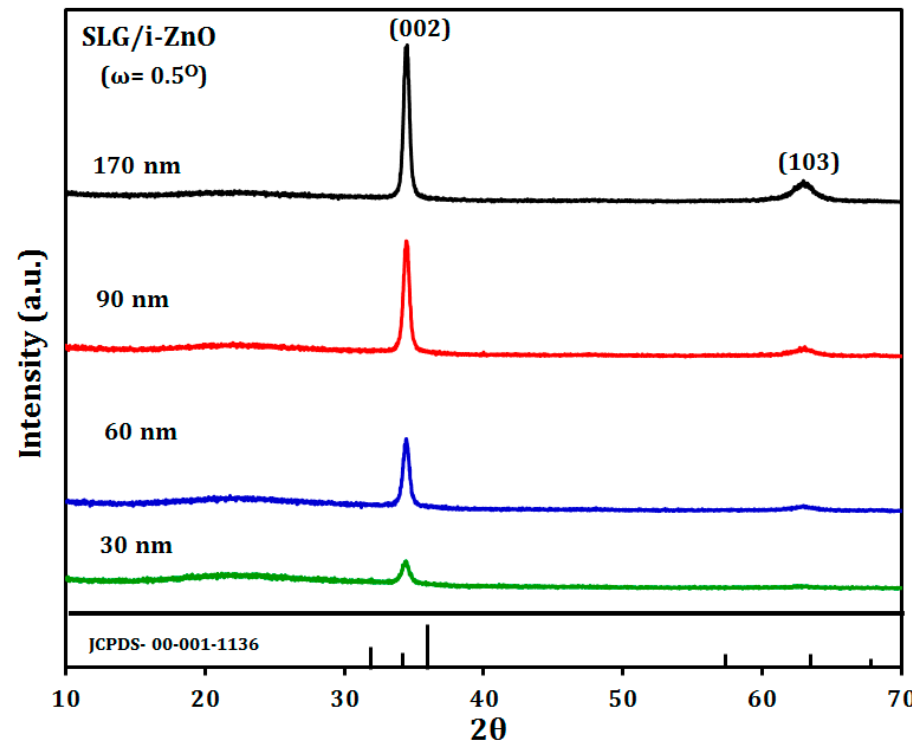
Figure 5. Grazing incidence X-ray diffraction patterns ( ω = 0.5 ° ) of the SLG/i- ZnO films prepared with a different thickness.